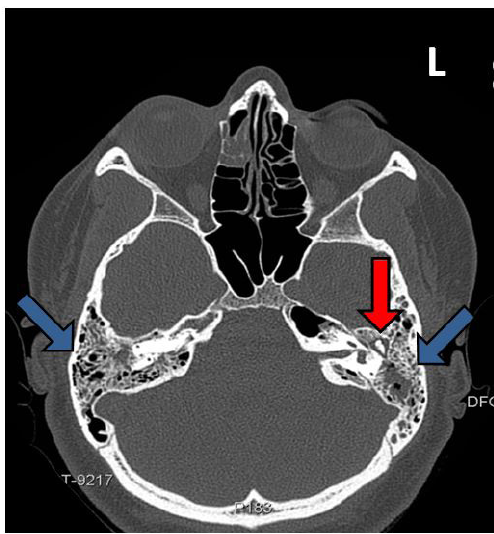
Image 1. Axial computed tomography of the mastoid shows near complete opacifications of bilateral mastoid air cells with coales - cence and erosions (blue arrows). Fluid is seen surrounding the ossicles of the left middle ear (red arrow).